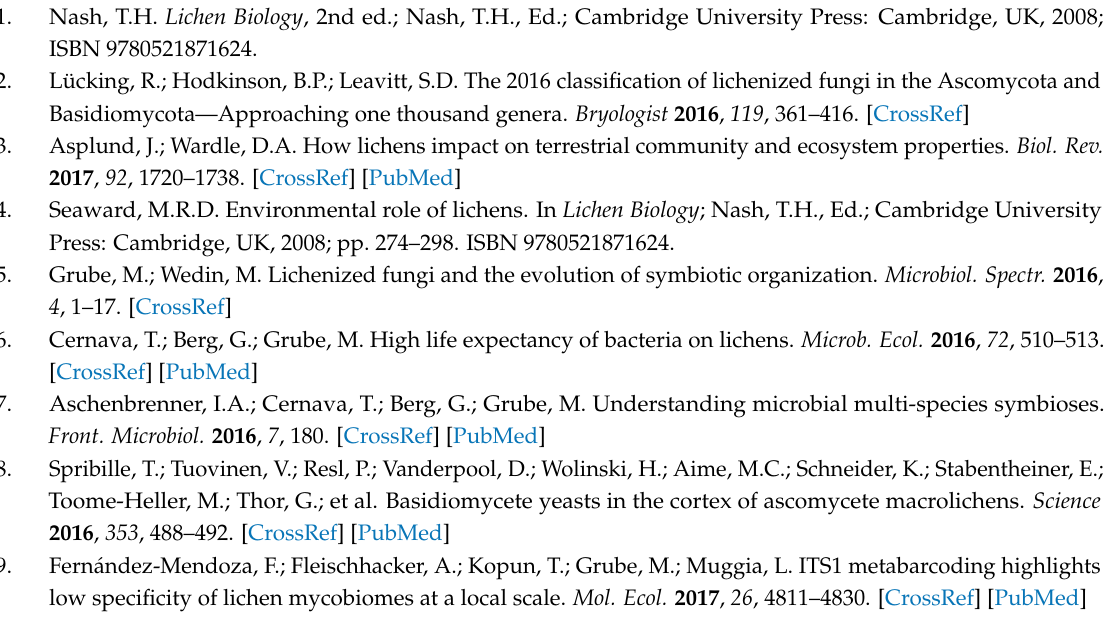
Supplementary Materials: The following are available online, Table S1: Genome Statistics and Completeness of Lichen-Forming Fungi; Table S2: Overview of Biosynthetic Gene Clusters in Evernia prunastri ; Table S3: Overview of Biosynthetic Gene Clusters in Pseudevernia prunastri ; Table S4: Functional Annotation of Evernia prunastri Cluster Genes; Table S5: Functional Annotation of Pseudevernia furfuracea Cluster Genes; Table S6: Reciprocal Best Blast Hits of Evernia prunastri and Pseudevernia furfuracea Cluster Genes; Table S7: List of Putative Regulatory Genes in Evernia prunastri and Pseudevernia furfuracea ; Figure S1: Phylogenetic Tree Based on the Ketosynthase (KS) Domain; Supplementary File S1: Ketosynthase (KS) Alignment for Phylogenetic Tree Reconstruction (FASTA); Supplementary Files S2: Predicted Gene Models for Seven Genomes of Lichen-Forming Fungi (GFF3); All output of antiSMASH analyses are available upon request from the corresponding